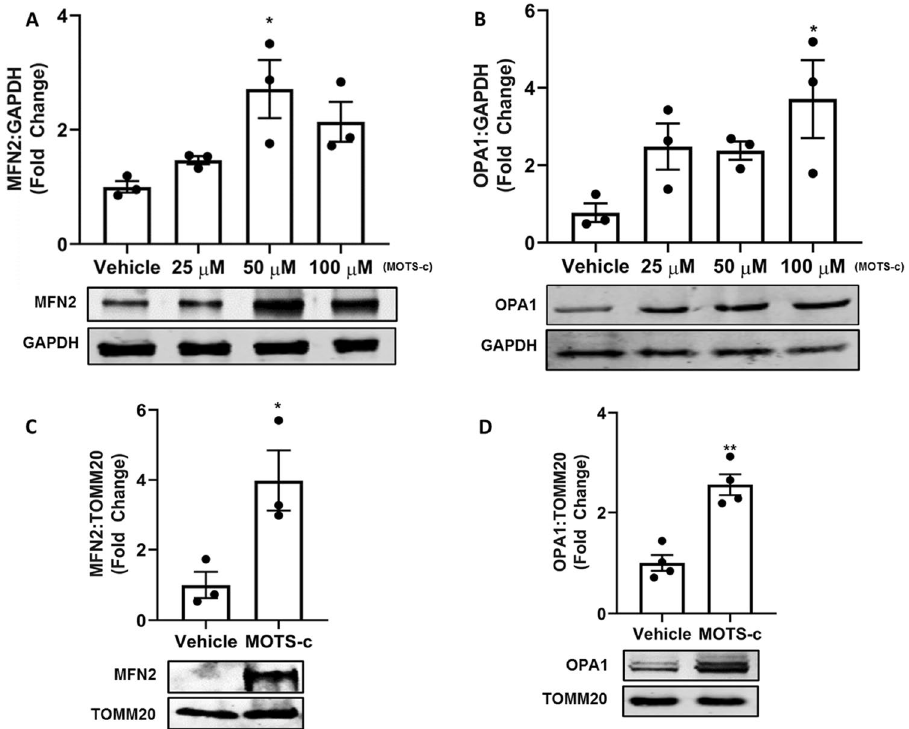
Figure 5. Treatment of U-2 OS cells with MOTS-c initiated mitochondrial fusion. Treatment with MOTS-c increased MfN2 and OPA1 protein expression in ( A , B ) whole cells and ( C , D ) mitochondria. U-2 OS cells grown in Dulbecco’s modified Eagle’s medium (DMEM) supplemented with 10% fetal bovine serum (FBS) plus 1% pen-strep were treated with vehicle (Nuclease-Free Water) or MOTS-c (25, 50 or 100 μM) for 48 h and